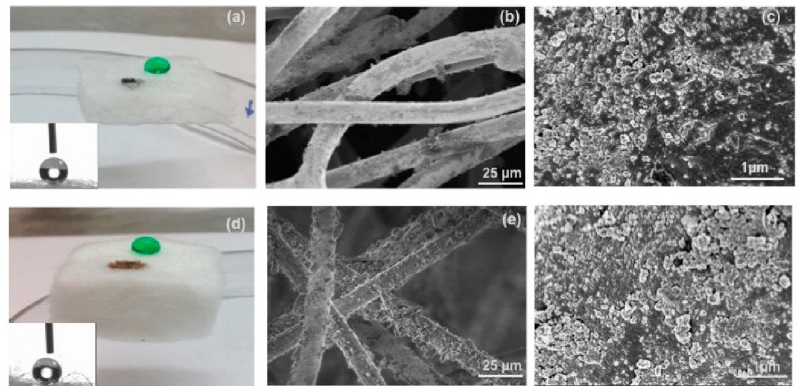
Figure 14. Optical interrogation of aerogel fabrics’ gross and fine structure. Image of a dyed-green water droplet and Iraq oil on the surface of ( a ) TW (6 mm thick) and ( d ) SL (10 mm thick). Insets are images from the WCA measurements. Please note that the TW used is thinner than SL. SEM images of the surfaces of ( b and c ) TW and ( e and f ) SL, where aerogel particles are visible on the fibers in high-resolution. Reprinted from [153] with permission, copyright American Chemical Society, 2016.